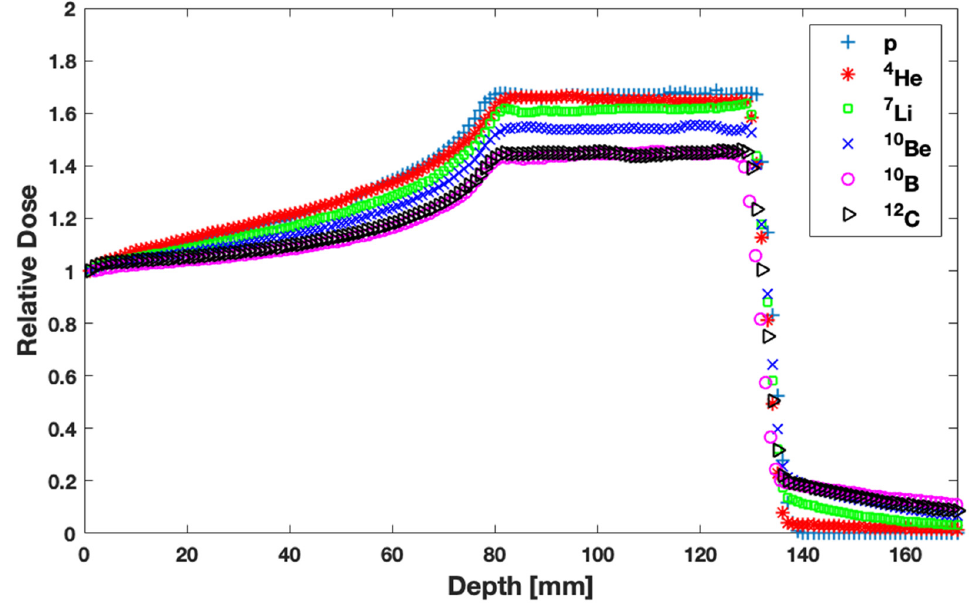
Figure 2. Percentage depth-dose curves (physical dose) for all single field ion beams considered in this study. Data have been normalized at the entrance dose.